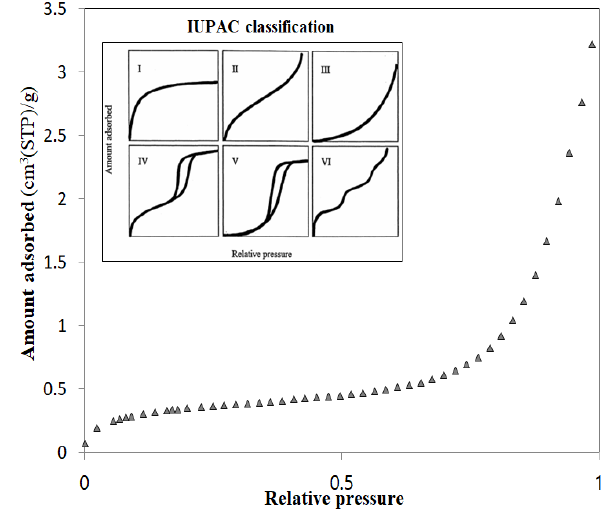
Figure 1. Adsorption-desorption isotherm curves of nitrogen.